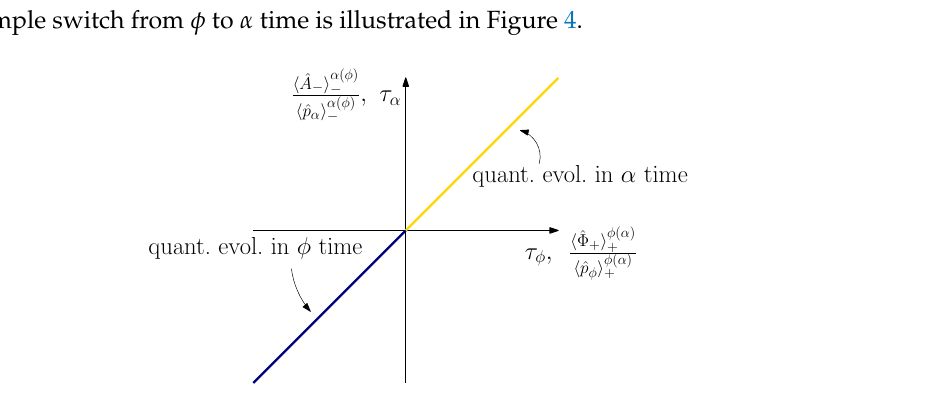
Figure 4. Illustration of the quantum relational evolution given in (47) and (48) for an internal = τ i = 0. The blue branch corresponds to the evolution of time switch from φ to α at τ f α φ (cid:68) (cid:69) α ( φ ) ( φ ) ˆ A / (cid:104) ˆ p α (cid:105) α − ( τ φ ) − in τ φ , while the golden branch depicts the evolution of − in τ α . Together they trace out a continuous classical trajectory, describing an expanding